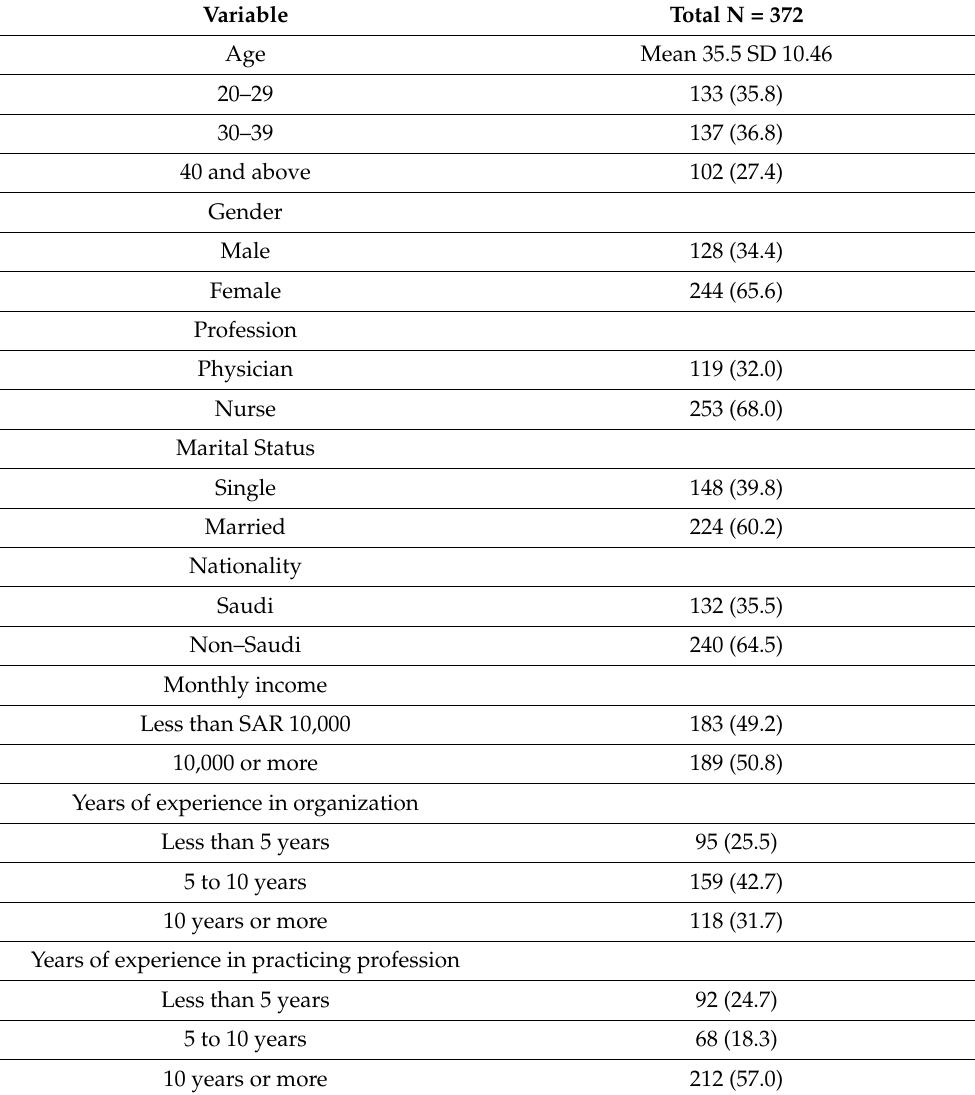
Table 1. Demographics of the healthcare